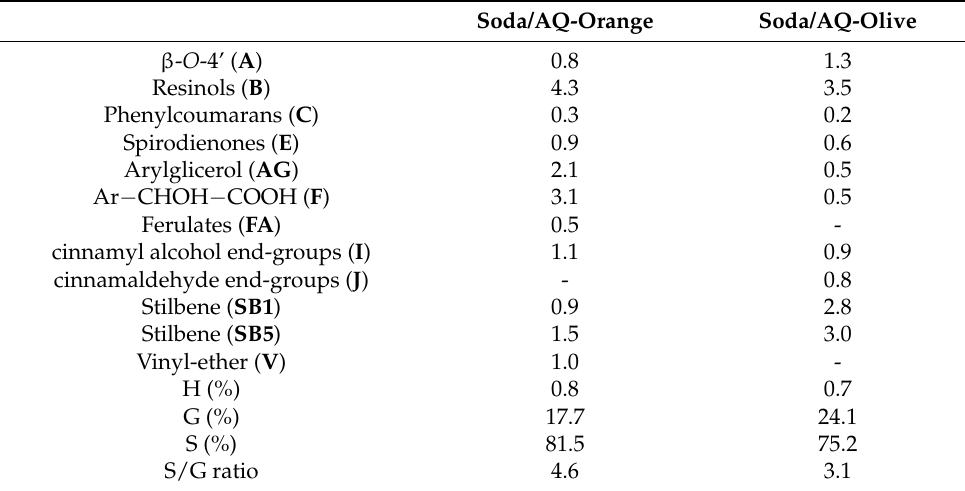
Table 2. Abundance of lignin substructures and end-groups (per 100 aromatic units) and aromatic units (molar percentage) from integration of 13 C- 1 H correlation peaks in the HSQC spectra of soda/AQ